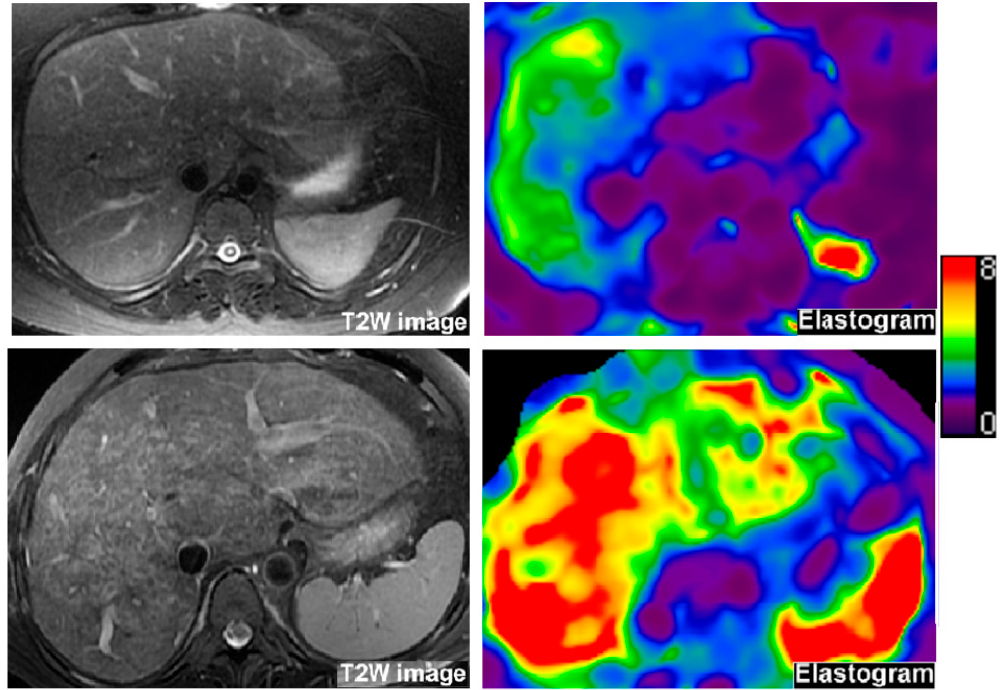
Figure 1. Magnetic resonance elastography images to measure liver stiffness in two patients with history of Fontan palliation. Left images: T2-weighted anatomic images. Right images: MR elastograms showing tissue